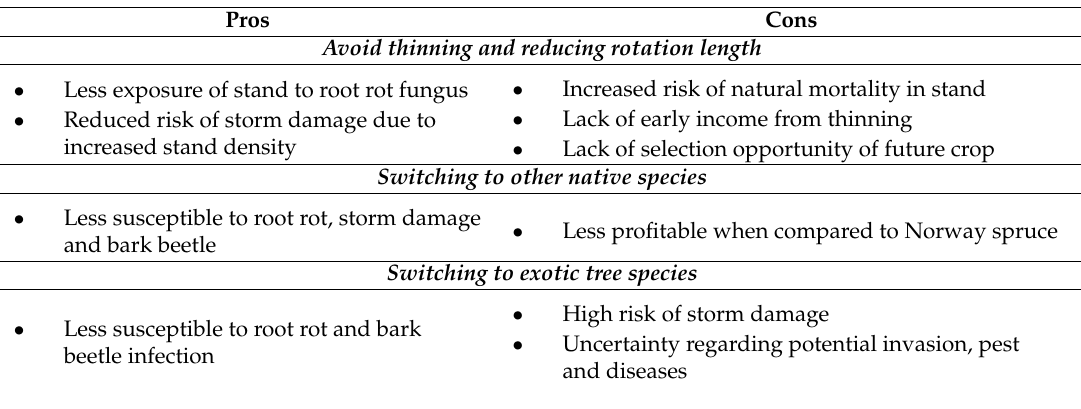
Table 3. Various adaptation strategies considered in this study and their pros and cons. Pros Cons Avoid thinning and reducing rotation